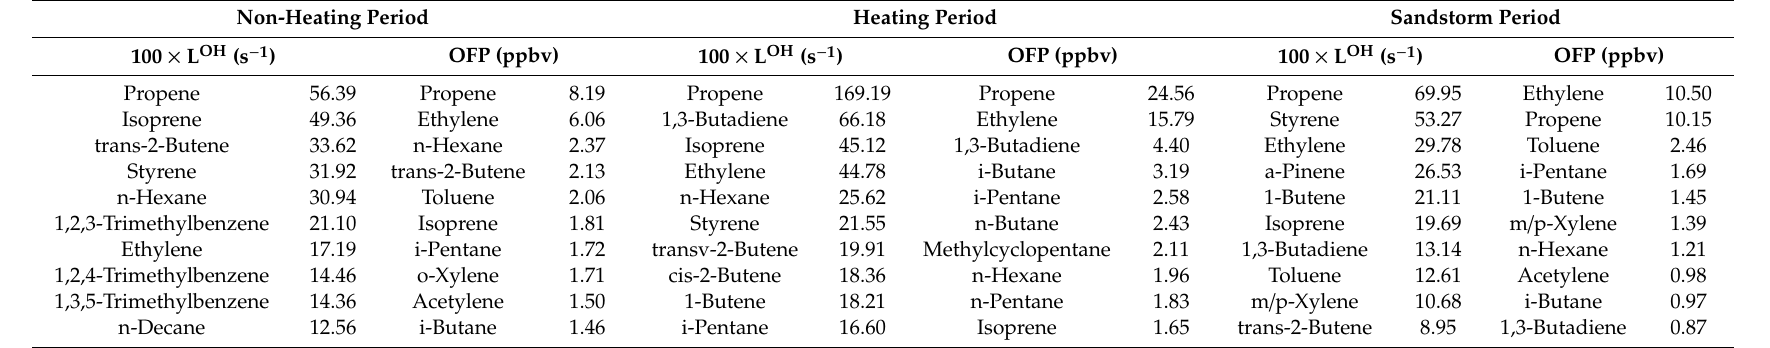
Table 2. Top ten species with the highest L OH and OFP values in the atmosphere of the Dushanzi